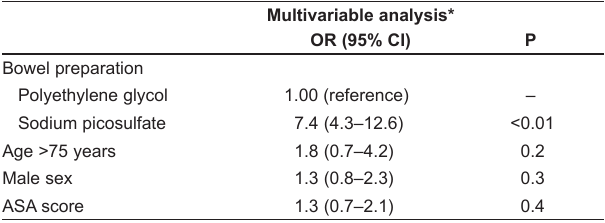
TAble 7 Independent predictors of polyp detection rate in screening